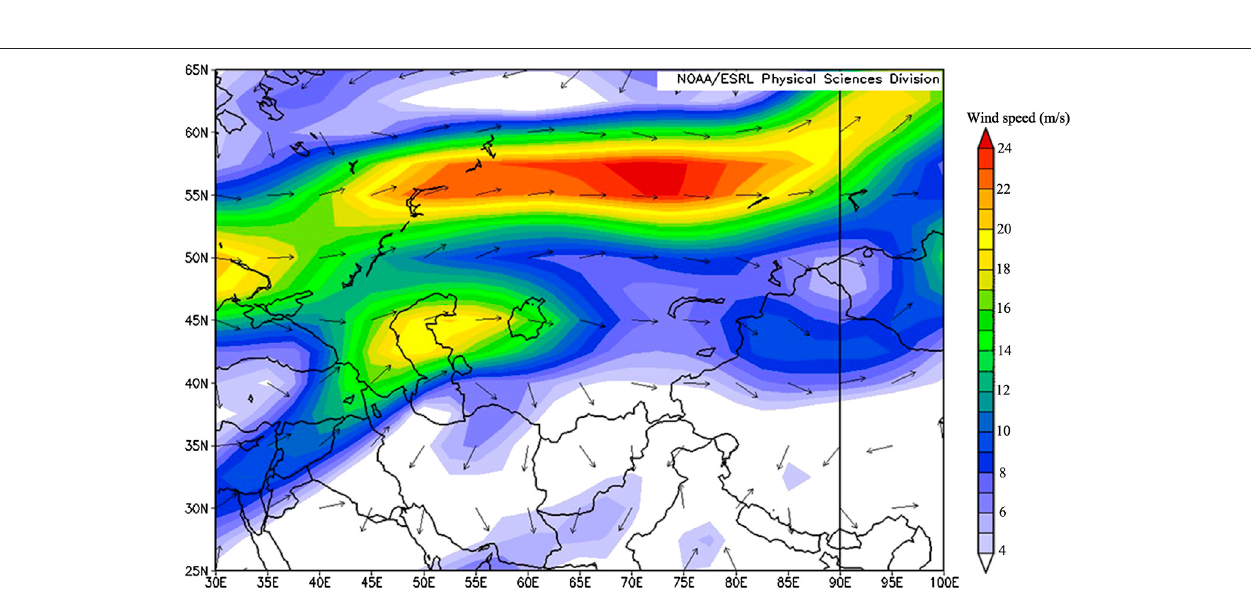
Figure 7 . During the dust event, air masses originated from the arid regions of the Eastern European plains, Kazakhstan and Kyrgyzstan. Affected by the westerlies, the cold air masses that